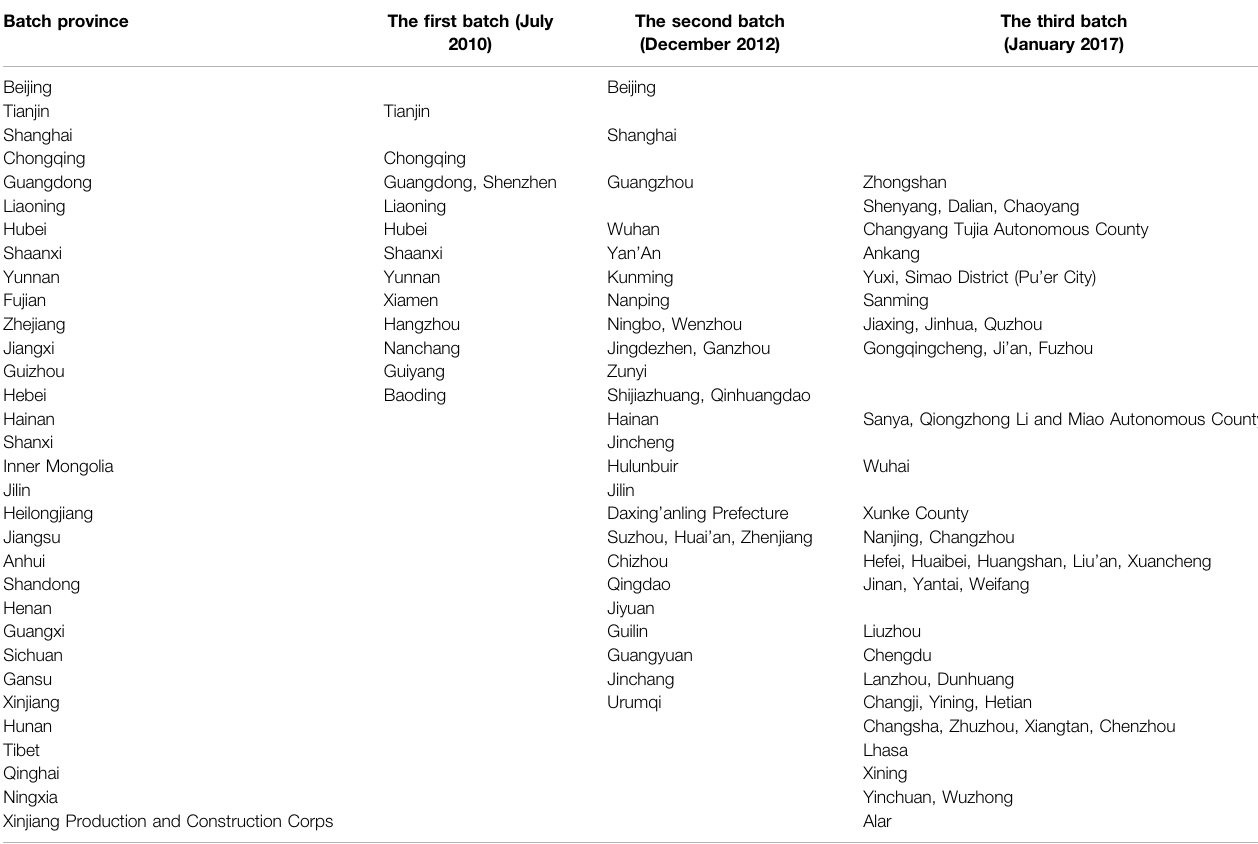
TABLE 1 | List of pilot low-carbon